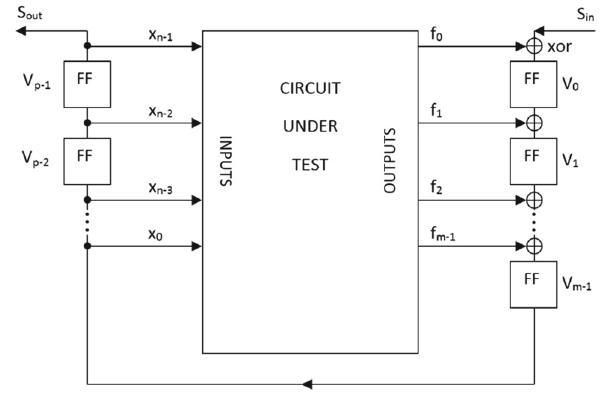
Fig. 1 Self-test path